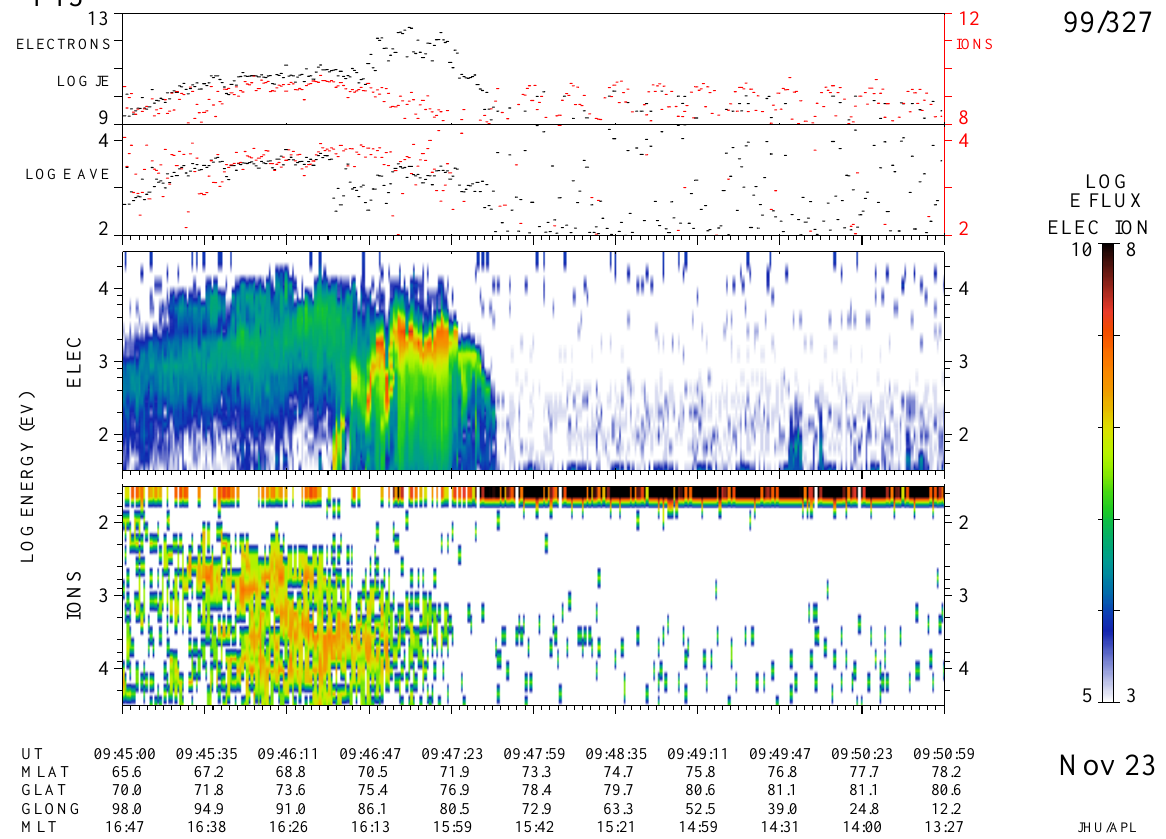
Fig. 7. Same as Fig. 5, showing a dusk pass of DMSP-F13 through the footprint of an adiaroic (non-reconnecting) open-closed boundary near 16:00 MLT. Note that no sheath-like precipitation was observed.